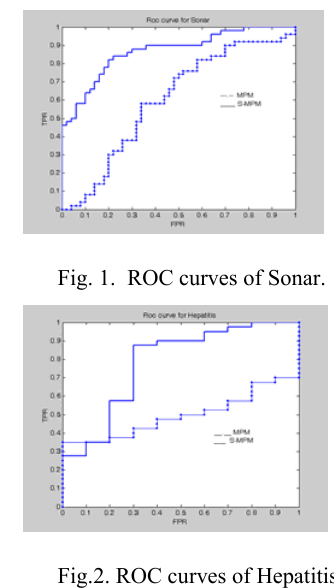
Fig. 7. ROC curves of Australian